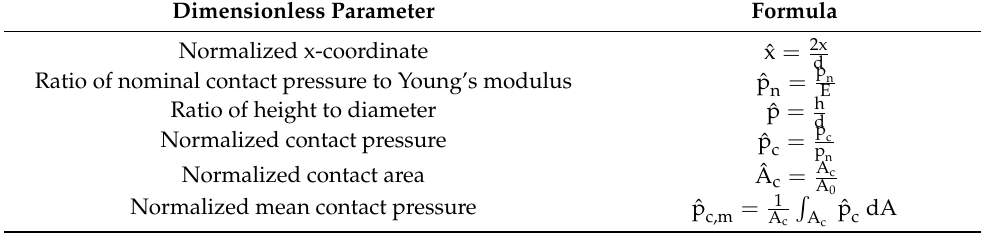
Table 2. Dimensionless parameters used in the parameter study.